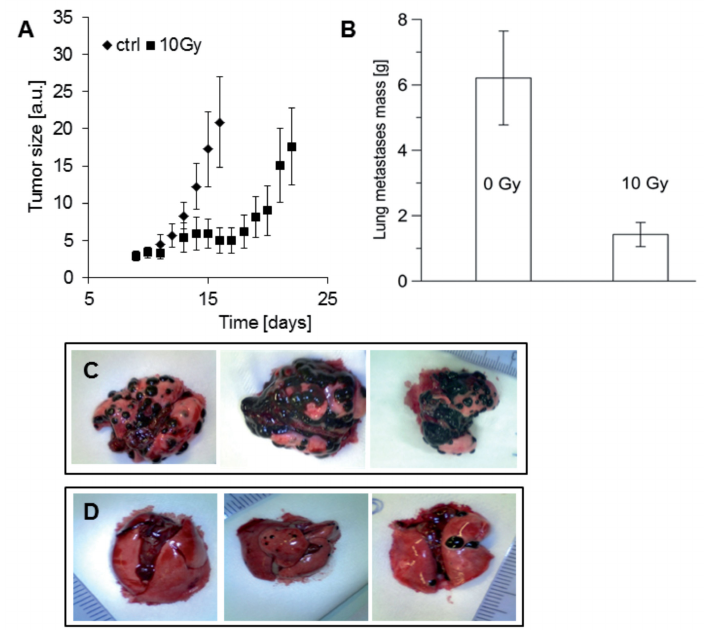
Figure 6. ( A ) Inhibition of BHM melanoma tumor growing in the hamster eye, irradiated with a proton beam at a single dose of 10 Gy ( n = 7, black square), as compared with the untreated control ( n = 6, black diamond). ( B ) The mass of lung metastases decreased 4.35 times as a result of the proton beam irradiation (10 Gy) of BHM melanoma tumor growing in the hamster eye ( p = 0.0052). Average mass with SEM is shown. The number of control animals was six, and the number of irradiated animals was seven. Representative isolated lungs with metastases from untreated ( C ) and irradiated ( D ) animals. Reproduced with permission from